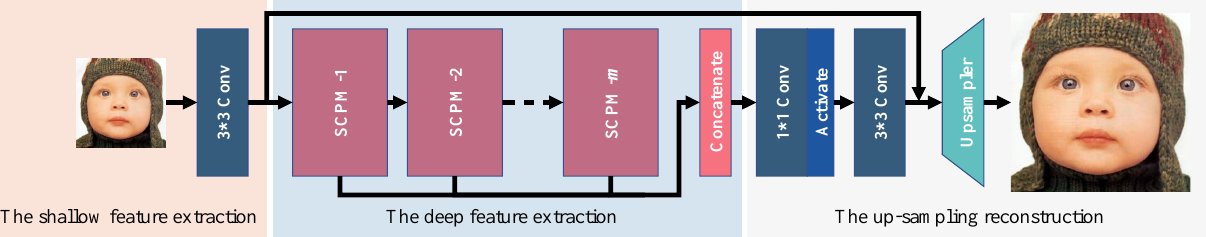
Figure 3. The whole architecture of our selective channel processing network (SCPN).